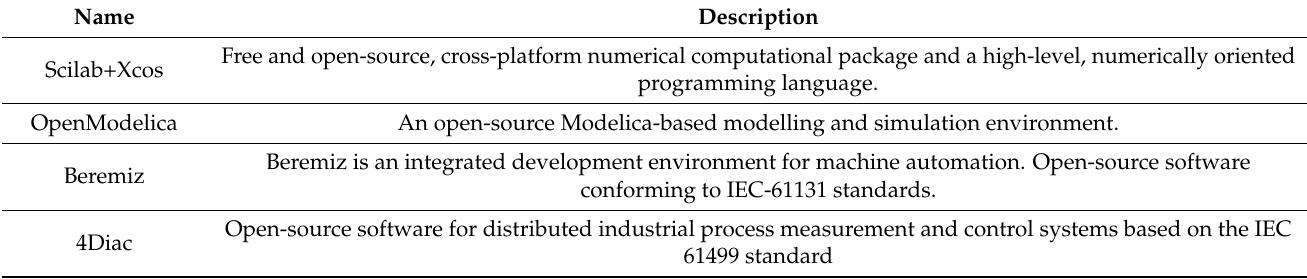
Table 9. Simulation